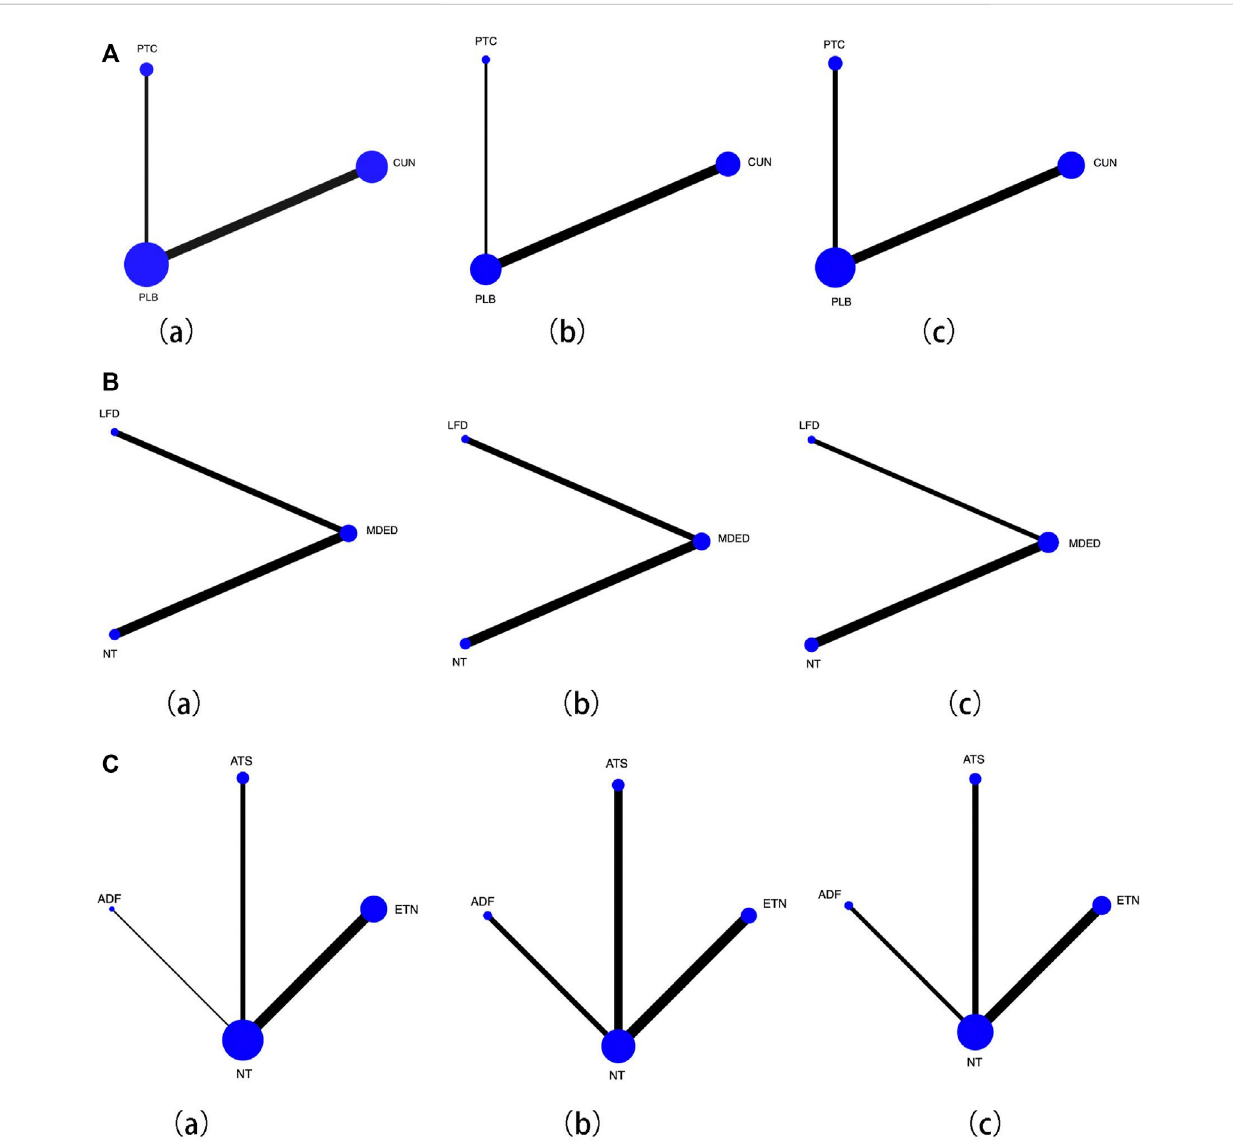
FIGURE 4 (A) Network map for effcacy of medication with placebo (PLB), (a) Forest plot effcacy of curcumin (CUN) and probiotics (PTC) with placebo in improving alanine aminotransferase (ALT), (b) Forest plot effcacy of curcumin (CUN) and probiotics (PTC) with placebo (PLB) in improving total cholesterol(TC),(c)Forestploteffcacyofcurcumin(CUN)andprobiotics(PTC)withplacebo(PLB)inimprovinglow-densitylipoproteincholesterol(LDL). Lines connect the interventions that have been studied in head-to-head comparisons in eligible RCTs. The width of the lines represents the total number of RCTs for each pairwise comparison. The size of each node is proportional to the number of randomized participants. (B) Network map for effcacy of diet with control, (a) Forest plot effcacy of mediterranean diet (MDED) and low-fat diet (LFD) with not have any type of treatment (NT) in improvingalanineaminotransferase(ALT),(b)Forestploteffcacyofmediterraneandiet(MDED)andlow-fatdiet(LFD)withnothaveanytypeoftreatment (NT) in improving total cholesterol (TC), (c) Forest plot effcacy of mediterranean diet (MDED) and low-fat diet (LFD) with not have any type of treatment (NT) in improving low-density lipoprotein cholesterol (LDL). Lines connect the interventions that have been studied in head-to-head comparisons in eligible RCTs. The width of the lines represents the total number of RCTs for each pairwise comparison. The size of each node is proportional to the number of randomized participants. (C) Network map for effcacy of lifestyle with control, (a) Forest plot effcacy of exercise training (ETN), accept theoretical suggestions (ATS) and alternate-day fasting (ADF) with not have any type of treatment (NT) in improving alanine aminotransferase (ALT), (b) Forest plot effcacy of exercise training (ETN), accept theoretical suggestions (ATS) and alternate-day fasting (ADF) with not have any type of treatment (NT) in improving total cholesterol (TC), (c) Forest plot effcacy of exercise training (ETN), accept theoretical suggestions (ATS) and alternate-day fasting (ADF) with not have any type of treatment (NT) in improving low-density lipoprotein cholesterol (LDL). Lines connect the interventions that have been studiedinhead-to-headcomparisonsineligibleRCTs.ThewidthofthelinesrepresentsthetotalnumberofRCTsforeachpairwisecomparison. Thesize of each node is proportional to the number of randomized